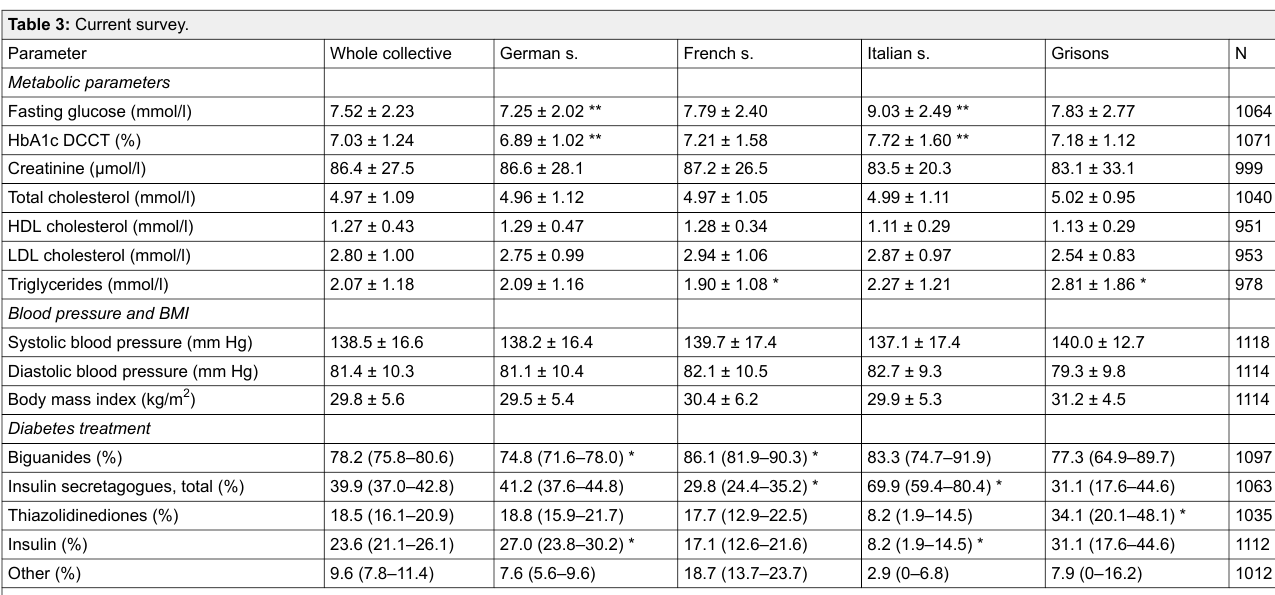
Table 3: Current